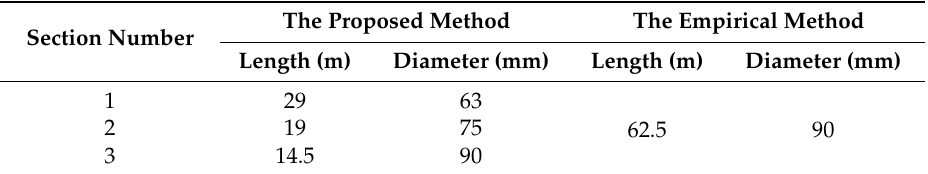
Table 2. Optimal design of the branch pipe of the typical BLPN